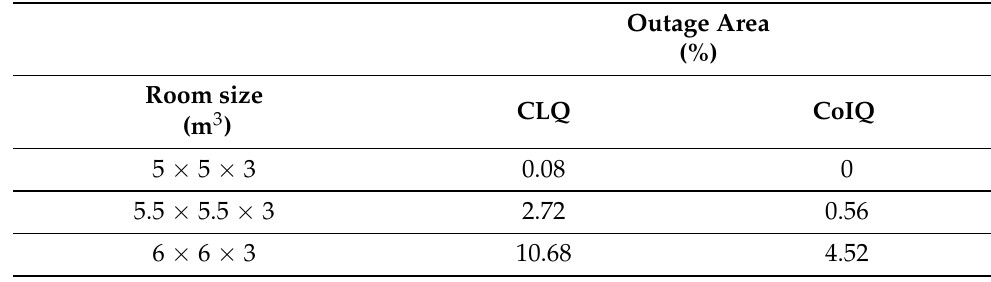
Table 4. Percentage Outage Areas for CLQ and CoIQ.